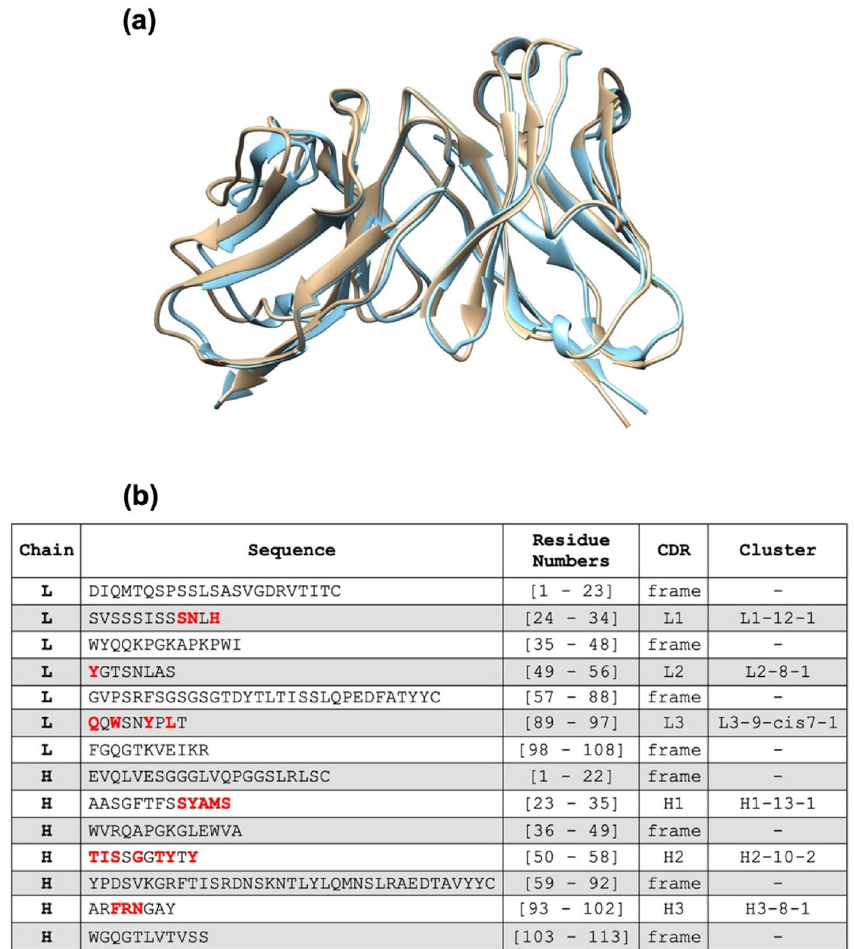
Figure 4. Structural comparison of parental ScFvM61B9 (gold ribbon) versus HuScFvM61B9 (blue ribbon) and identification and clustering of HuScFvM61B9 CDRs. The conformational structures were obtained from the BioLuminate 4.0 antibody humanization process. The calculated RMSD between 108 pruned atom pairs is 0.758 Å (across all 115 pairs: 1.004) as per the MatchMaker function in the UCSF Chimera 1.15 software with the Needleman-Wunsch algorithm/BLOSUM-62. ( b ) The amino acids of each CDR interacting with the epitope on domain 1 of CD147 are depicted in red